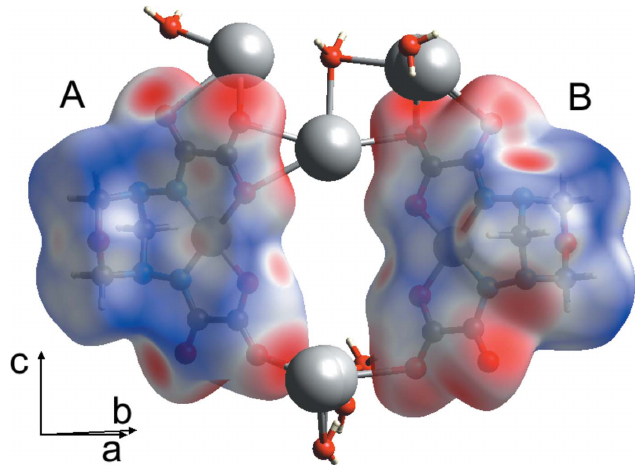
Figure 8 The Hirshfeld surfaces of the two complex anions (A = Ni and B = Ni B ) mapped over d norm .